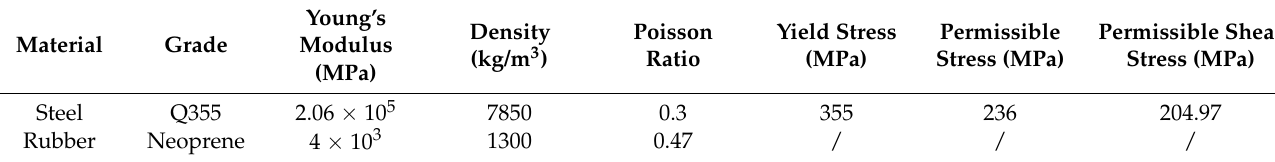
Table 1. Material characteristics of the expansion